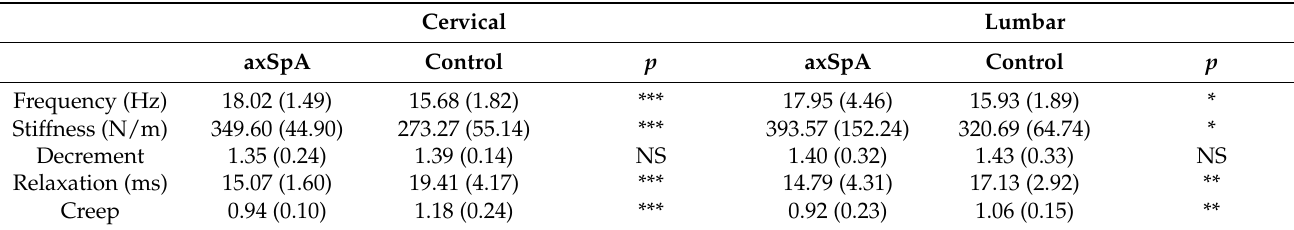
Table 2. Results of muscle tone measurements in axSpA patients ( n = 34), healthy controls ( n = 34) and significance of differences between both